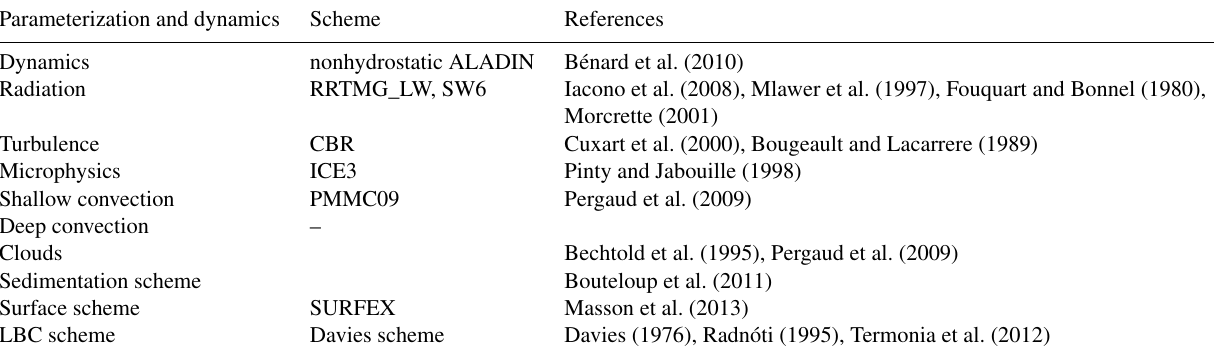
Table 3. The AROME CMC.